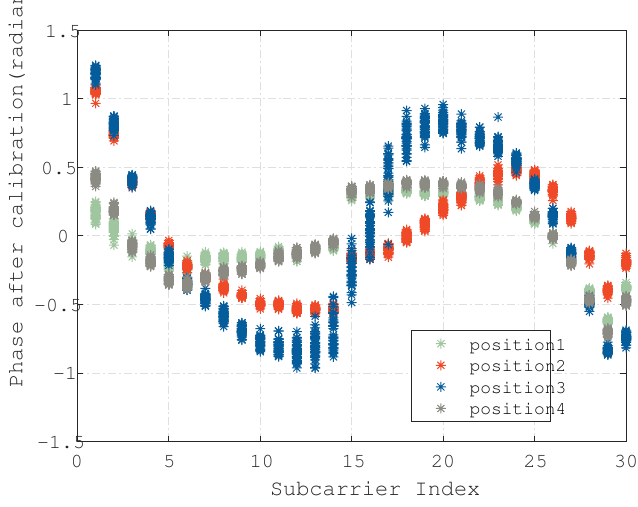
Figure 8. Phases in four different positions on the first antenna.